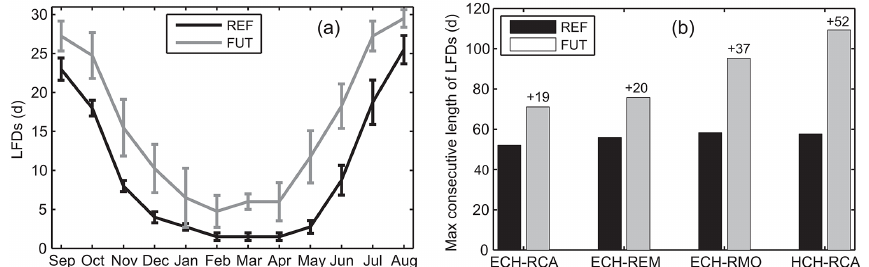
Figure 10. (a) Mean monthly number of low flow days (LFDs) in REF (black) and FUT (gray). Bars are mean ± standard deviation across the CMs. (b) Mean annual maximum consecutive length of LFDs in REF (black) and FUT (gray) periods.